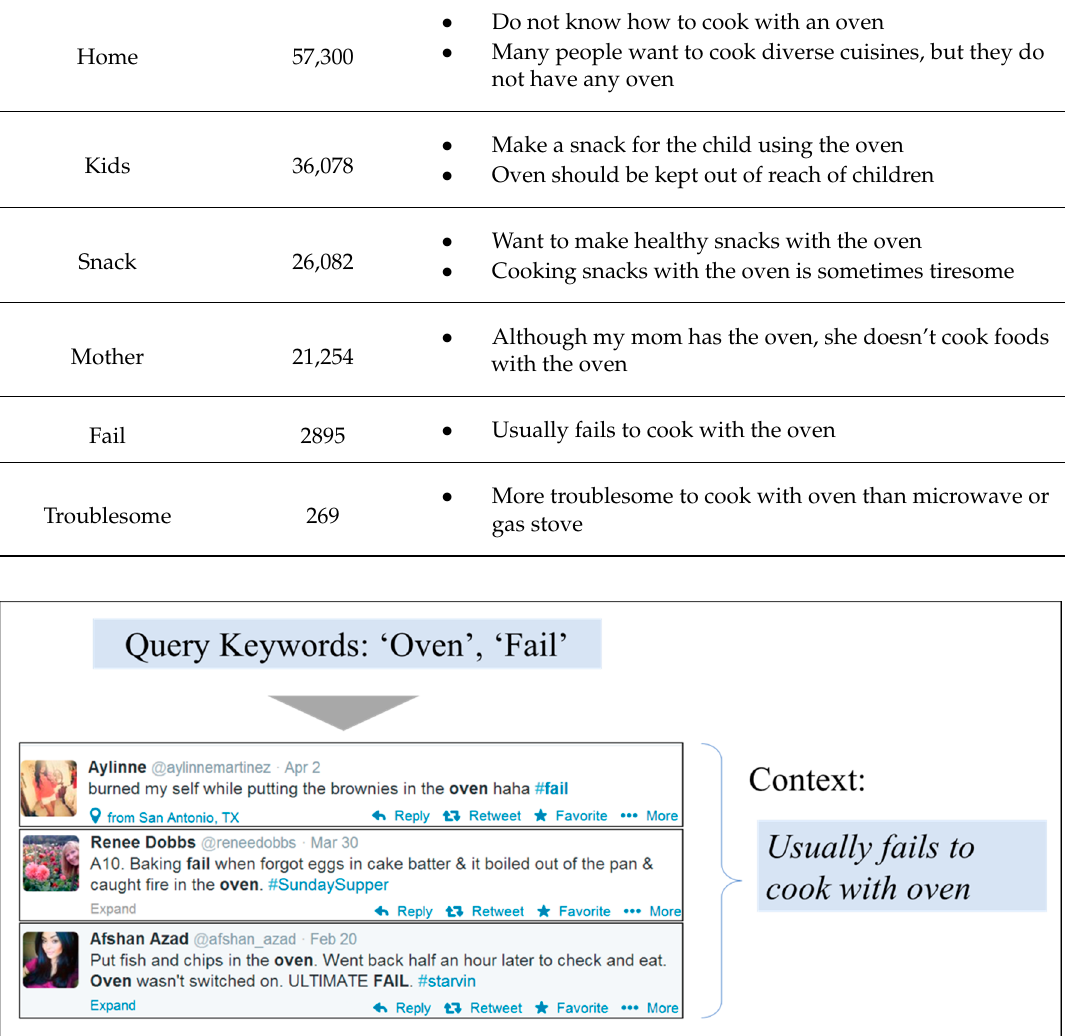
Figure 8. Context Tree for the primal keyword ‘oven’. 5.2. Developing User Scenarios After identifying customers’ needs from social media, it is necessary to create users’ scenarios in the same way as existing NPD processes. For this purpose, a task force team is made to create